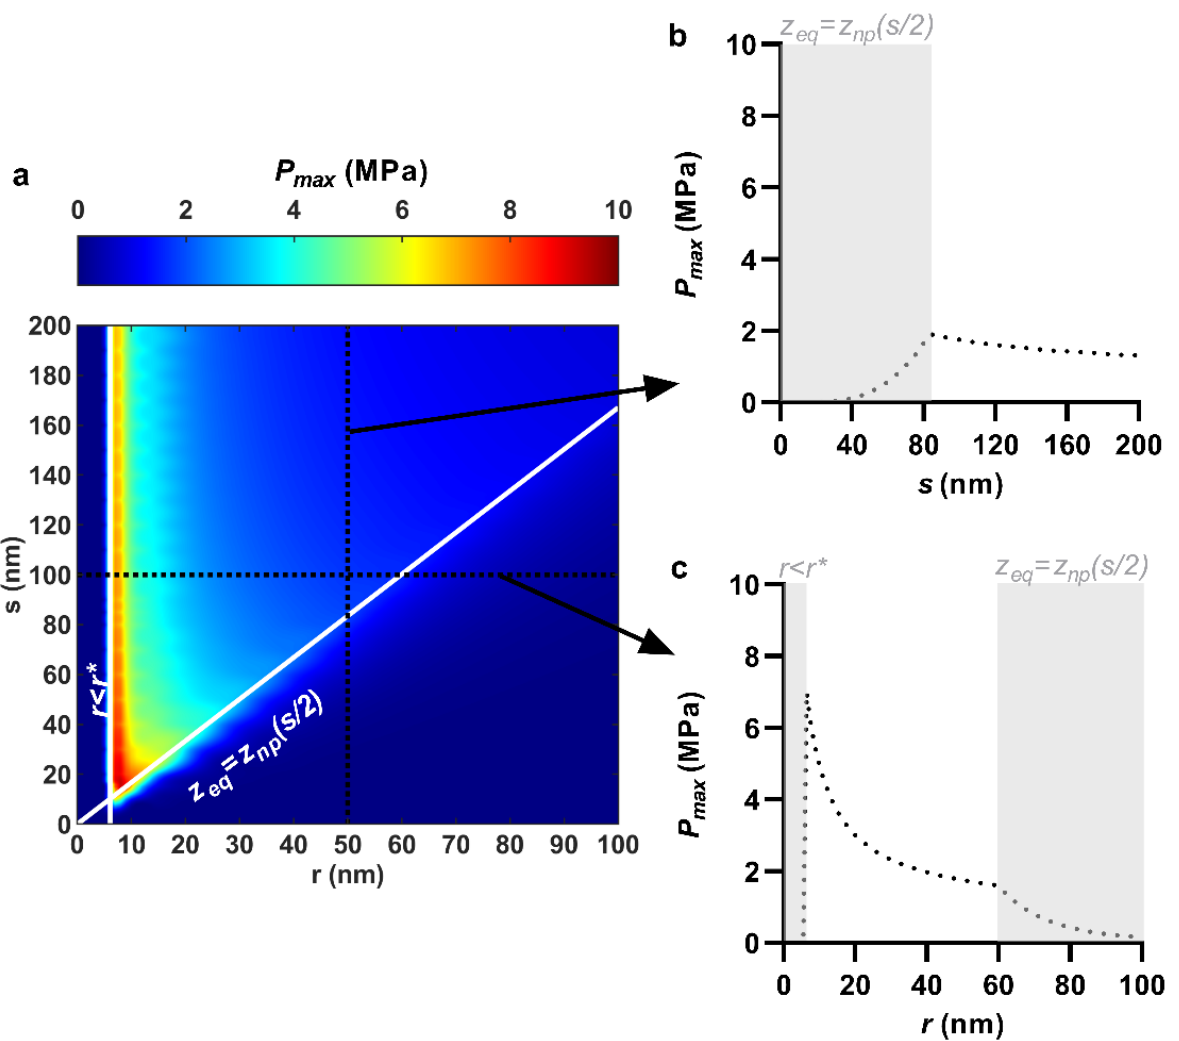
Figure 4. Effect of nanopillar quasi-tip radius, r , and center spacing, s , on maximum contact pressure, P max . ( a ) Combined effects of quasi-tip radius and center spacing shown as a contour plot; ( b ) Selective effect of center spacing, at a fixed quasi-tip radius of 50 nm; ( c ) Selective effect of quasi-tip radius, at a fixed center spacing of 100 nm. r < r* and z eq = z np ( s /2) indicate discontinuities due to emergence of a bending energy barrier and closing of interspace, respectively. For all cases, nanopillar height, pattern ordering, and work of adhesion were 200 nm, hexagonal and 20 mJ/m 2 , respec- tively.